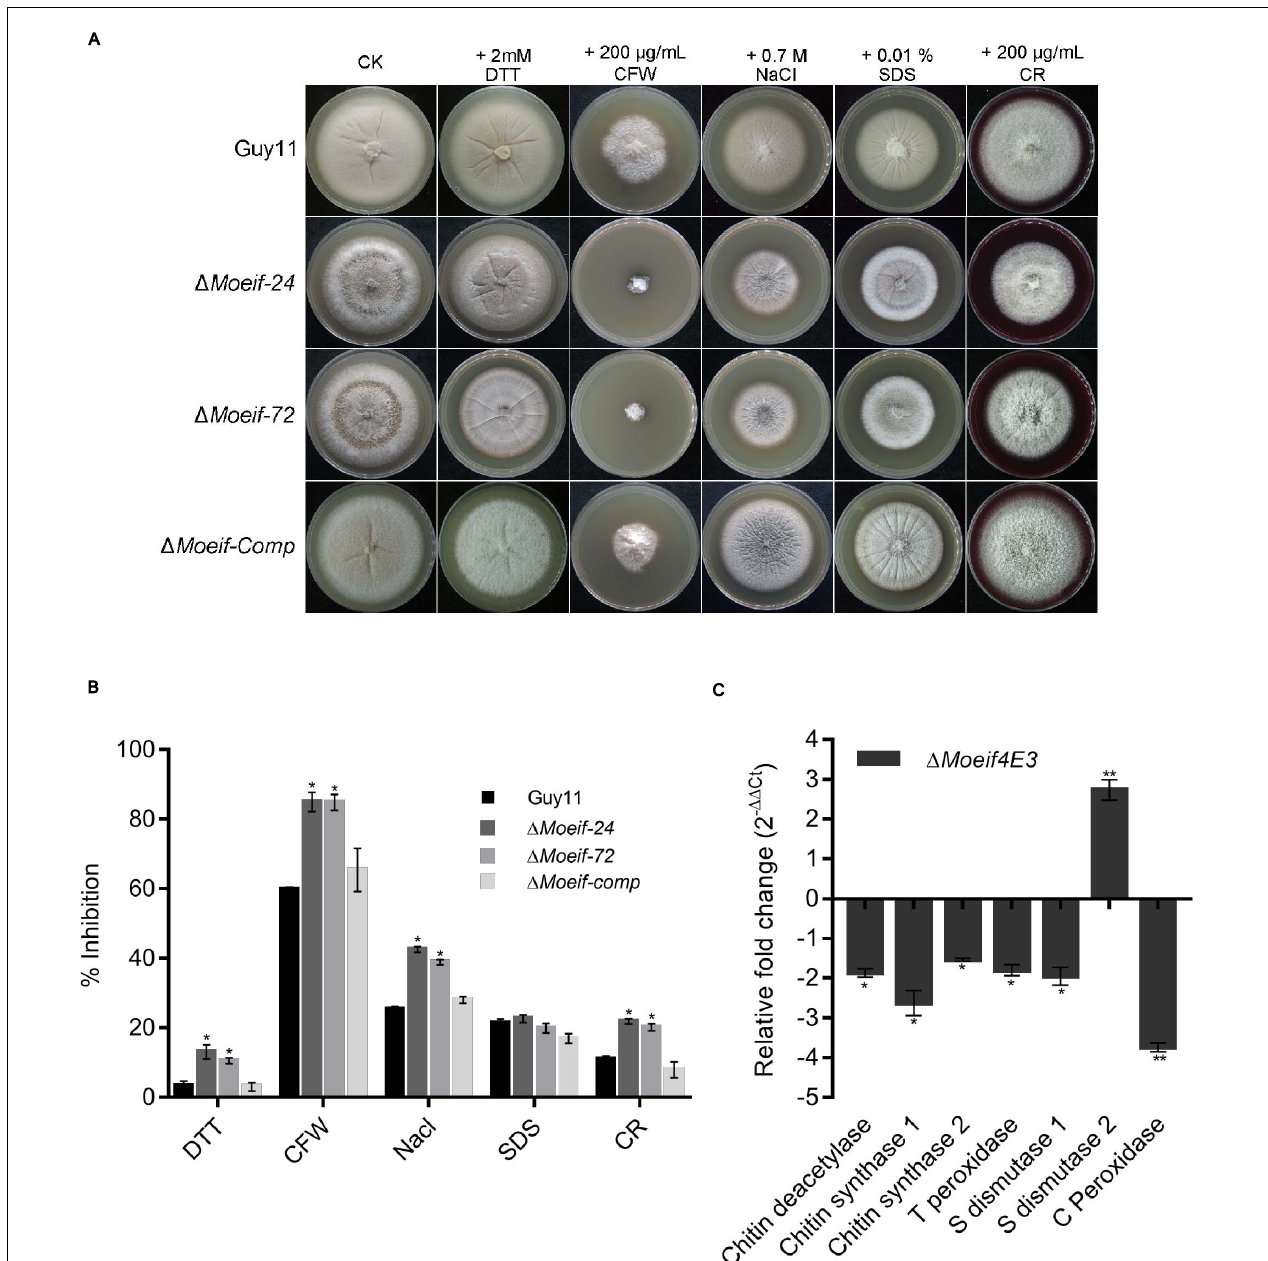
FIGURE 7 | MoeIF4E3 deleted strains are sensitive to various stress in M. oryzae . (A) Colony morphology of Guy11 and MoeIF4E3 deletion mutants on CM plates amended with different stress-inducing osmolytes. The colonies were photographed at 10 days post-inoculation. (B) Statistical analysis of growth inhibition rate of respective mutants and the wild-type strains under different stresses. The percent inhibition was obtained using this formula: Inhibition rate = (the diameter of untreated strain – the diameter of treated strain)/ (the diameter of untreated strain × 100%). Statistical evaluation of percent inhibition was done using non-parametric ANOVA, using the GraphPad Prism7 software. Error bars represent standard deviation from three replications. (C) Expression profiling of different cell-wall-related enzymes during vegetative growth of MoeIF4E3 deleted mutant and Guy11 using qRT-PCR. Error bars represent standard deviation (SD). SD was calculated from three independent biological replications and three technical replicates, and significant levels were estimated using t -tests (* p < 0.05; ** p <